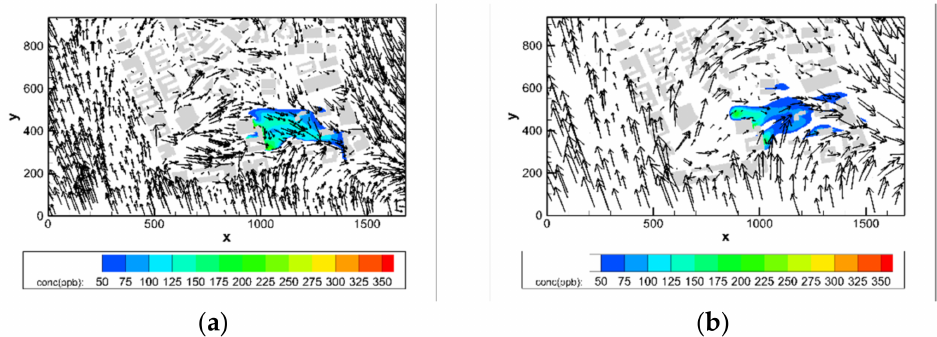
Figure 9. Simulated concentrations (ppb) and wind vector fields of the LST at 20:40, 9 August LST: ( a , c , e ) at z = 1.5 m; ( b , d , f ) at z = 21.5 m; ( a , b ) unstable condition; ( c , d ) neutral condition; ( e , f ) stable